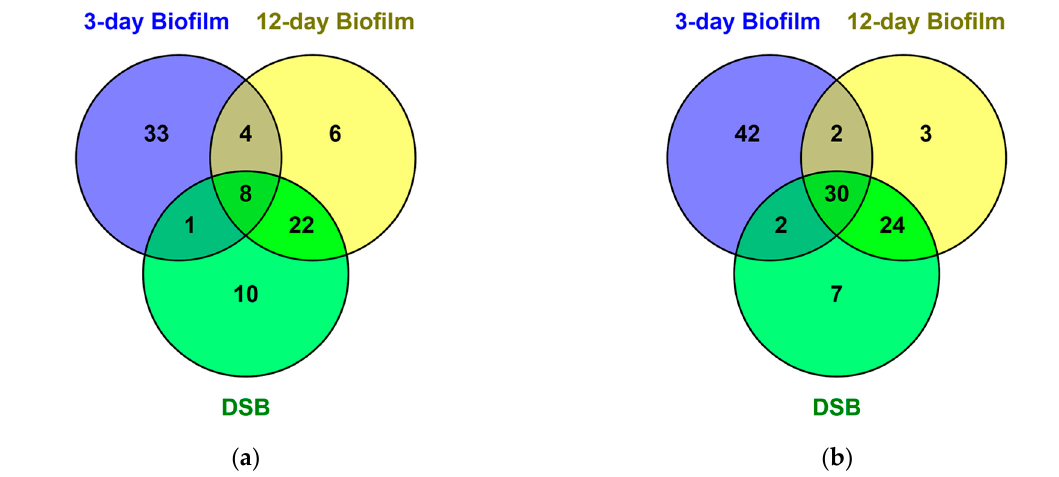
Figure 1. This Venn diagram represents identified proteins dysregulated >2-fold, p < 0.05 in comparison with 24 h planktonic culture. Proteins significantly upregulated ( a ) or downregulated ( b ) in 3-day hydrated, 12-day hydrated, and dry surface biofilm (DSB).